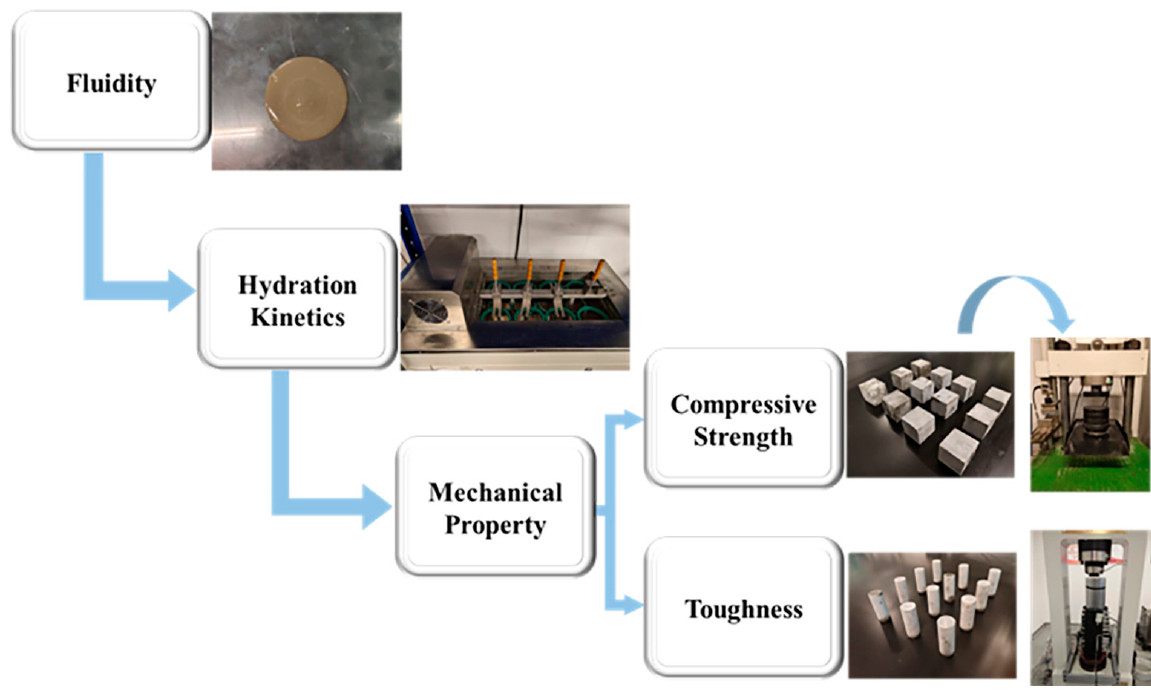
Figure 2. Experiments with modified